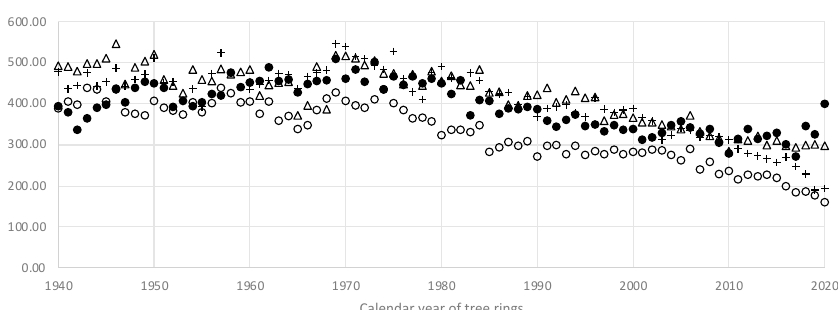
Figure 6. An example macrotrend in Ca counts across the tree rings facing the cardinal directions in pine #1. Legend: east (•), west ( Ο ), north ( Δ ), south (+).